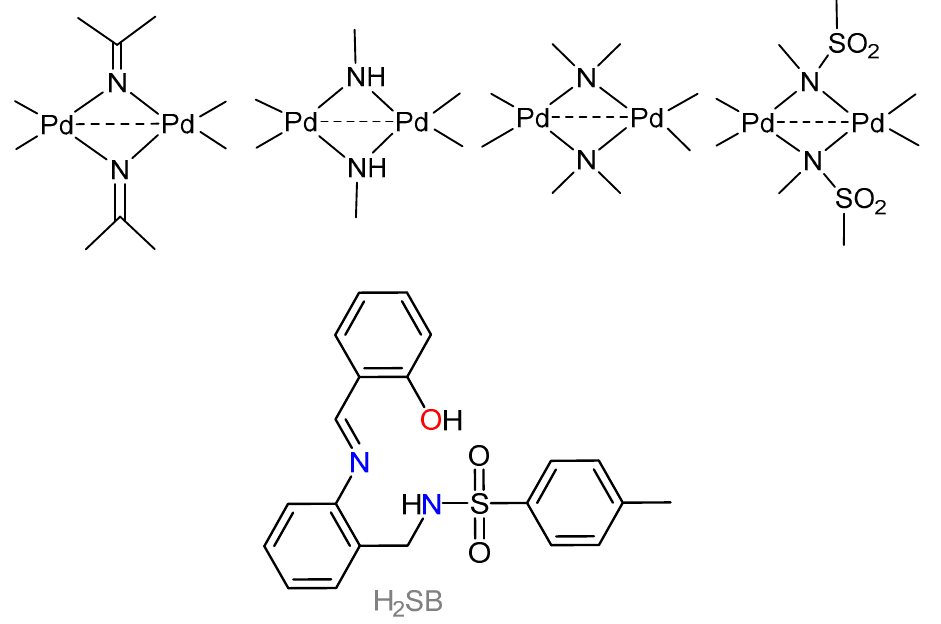
Figure 1. Schematic representation of the µ 2 – N bridges reported for dinuclear palladium complexes crystallographically characterized (top), and the tridentate Schiff base H 2 SB used in this work (bottom).